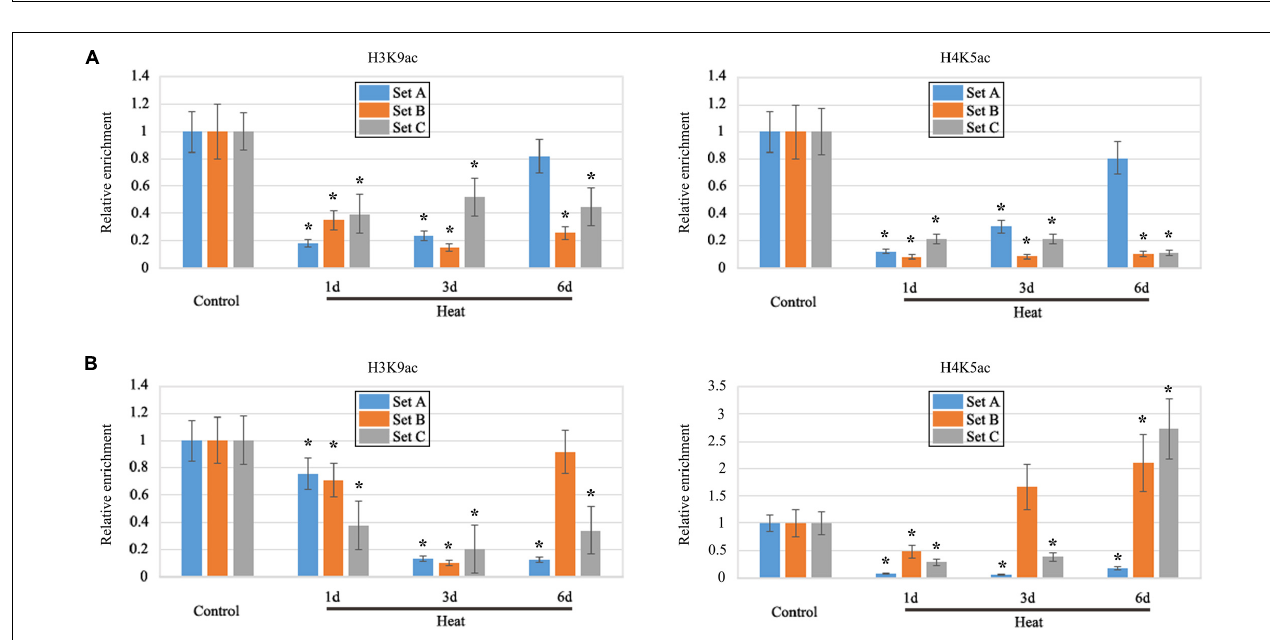
FIGURE 5 | qRT-PCR analysis of the expression levels of ZmHO-1 and ZmGSL-1 genes at 1, 3, and 6 days under heat stress. The transcription level of ZmHO-1 (A) and ZmGSL-1 (B) were significantly inhibited under heat stress. The relative expression level was evaluated from three biological replications. Asterisk ( ∗ ) indicated that the expression level of the heat treatment group was significantly different from that of the control group ( t -test, p < 0.01).